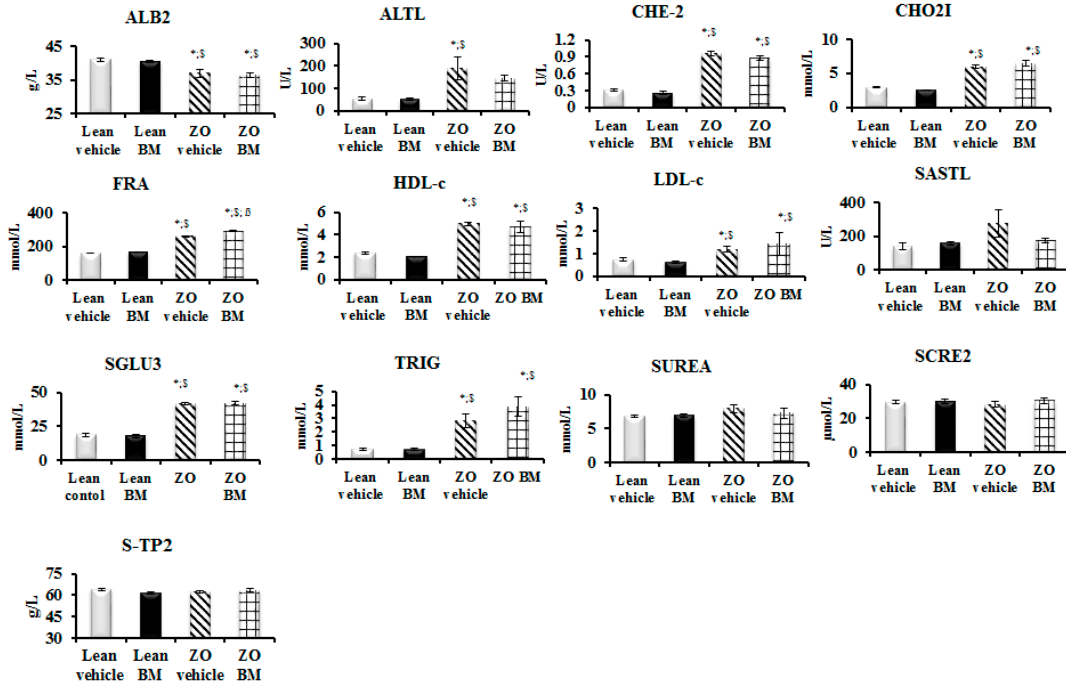
Figure 4. Effect of bitter melon (BM) extract on serum cardiovascular analytes in peripheral blood. Lean or Zucker Obese (ZO) rats ( n = 10 animals in each group), fed daily by gavage, for six weeks with mucin–water vehicle, or BM extract of 400 mg/kg body weight. Peripheral blood samples collected from the jugular vein at the end of treatment periods, was analyzed for albumin (ALB2), alanine aminotransferase (ALTL), cholinesterase (CHE-2), total cholesterol (CHO2I), fructosamine (FRA), high-density lipoprotein cholesterol (HDL-c), low-density lipoprotein cholesterol (LDL-c), aspartate aminotransferase (SASTL), serum glucose (SGLU3), triglycerides (TRIG), serum urea (SUREA), serum creatinine (SCRE2) and total protein (S-TP2). Outcomes are expressed as the average content of each analyze in mmol/L ± SEM. Significance level of difference ( p ) between average outcome values shown in histograms, is p < 0.05, or less, indicated as follows: * p < 0.05 versus Lean IR values, $ p < 0.05 versus Lean BM values, ß p < 0.05 versus ZO values.